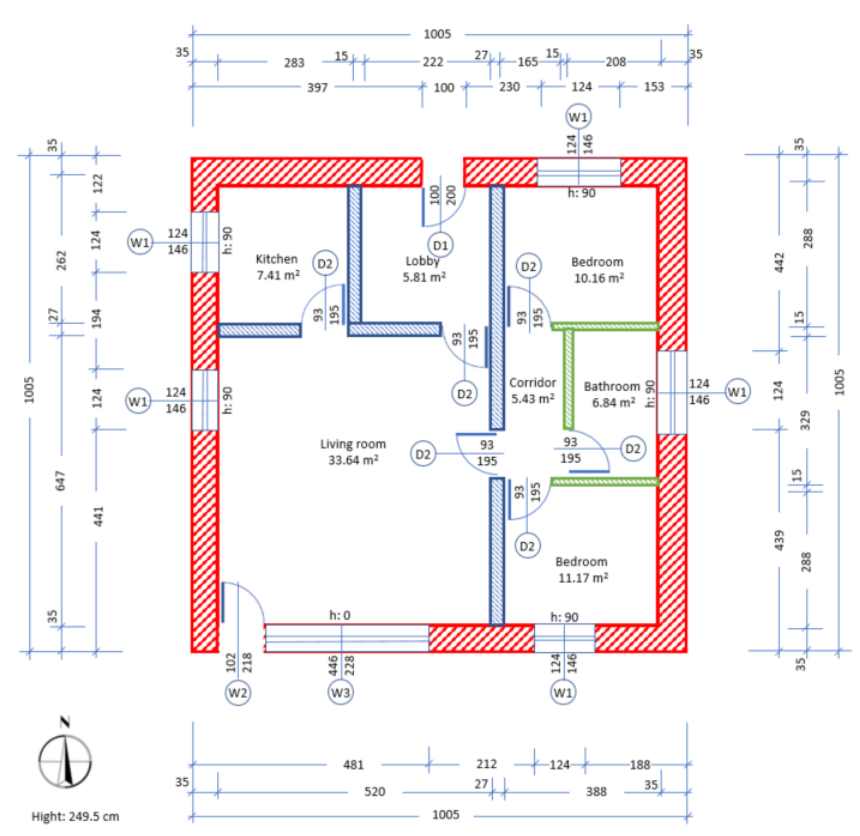
Figure 2. The twin house layout and dimensions (centimeters).